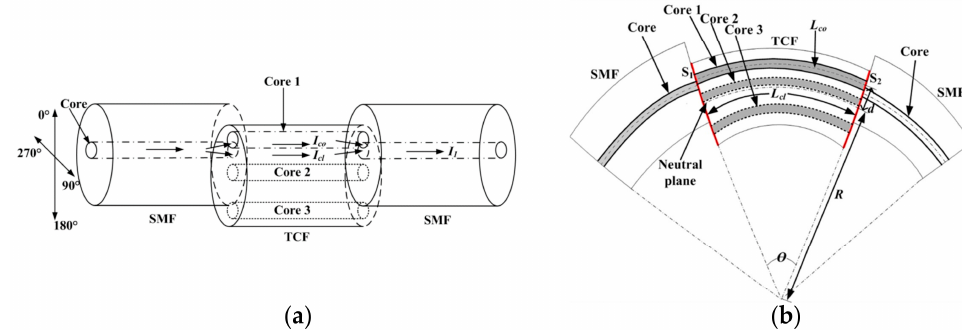
Figure 14. ( a ) Schematics of a three ‐ core ‐ fiber ‐ based MZI for directional bending sensing. ( b ) An illustration of the bent three ‐ core MZI [53].